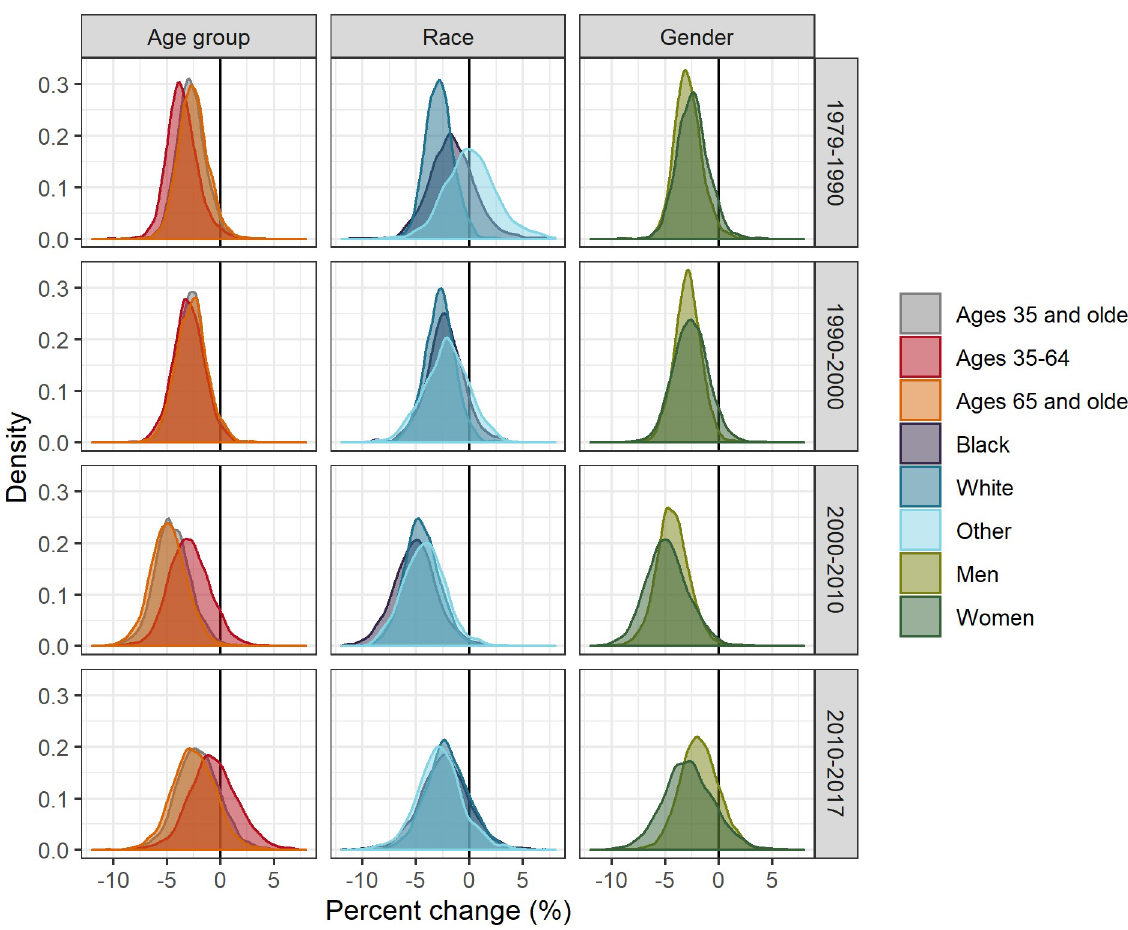
Fig 3. Distributions of percent change in county-level CHD death rates by time period, age group, race, and gender, United States, 1979– 2017. Race and gender groups are ages 35 and